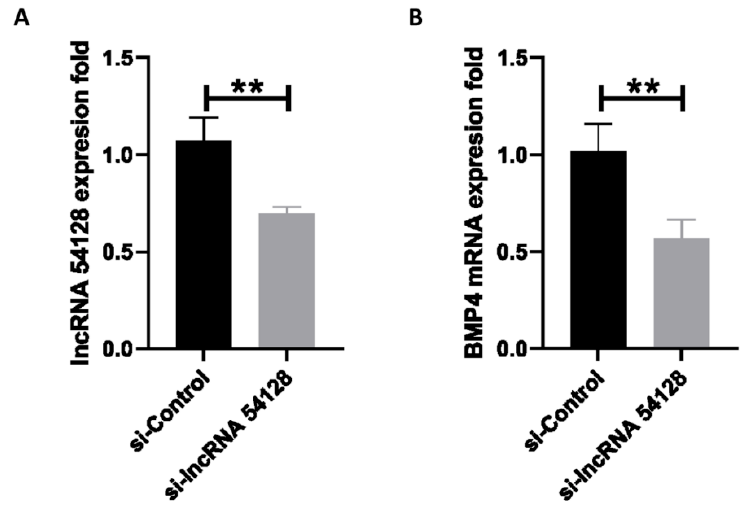
Figure 6. Effect of silencing LncRNA 54218 on BMP4 transcription. LMH cells were transfected with either the siControl or si LncRNA 54218 and then infected with FAdV-4 (MOI = 0.1) for 36 h. The transcription levels of ( A ) LncRNA 54218 and ( B ) BMP4 were analyzed by RT-qPCR. The data represent the mean ± SD of three independent experiments. p values were calculated using Student’s t test. An asterisk indicates a comparison with the indicated control. ** p < 0.01, n.s., not significant.